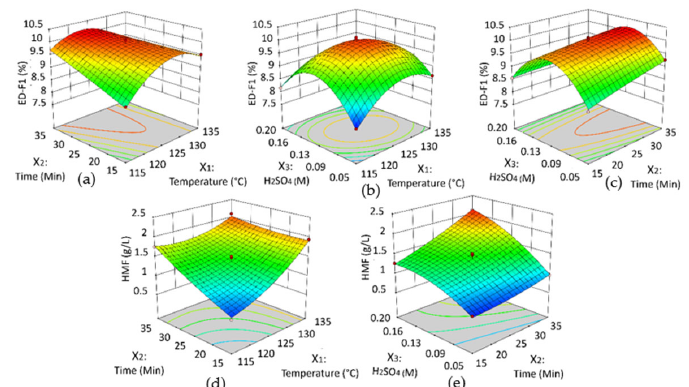
Figure 4. Three-dimensional response surface plots showing the effects of temperature, time and H 2 SO 4 on ED-F1 yield ( a – c ) and HMF ( d , e